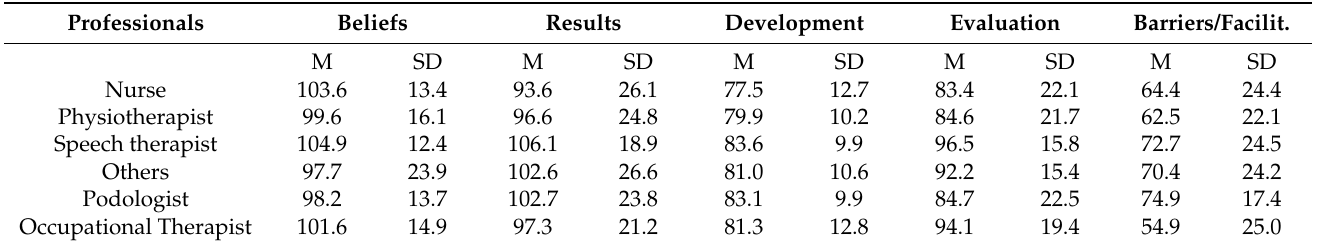
Table 3. Descriptive analysis by professional category on the subscales of the HS-EBP 30 questionnaire (mean and standard deviation). Development Evaluation